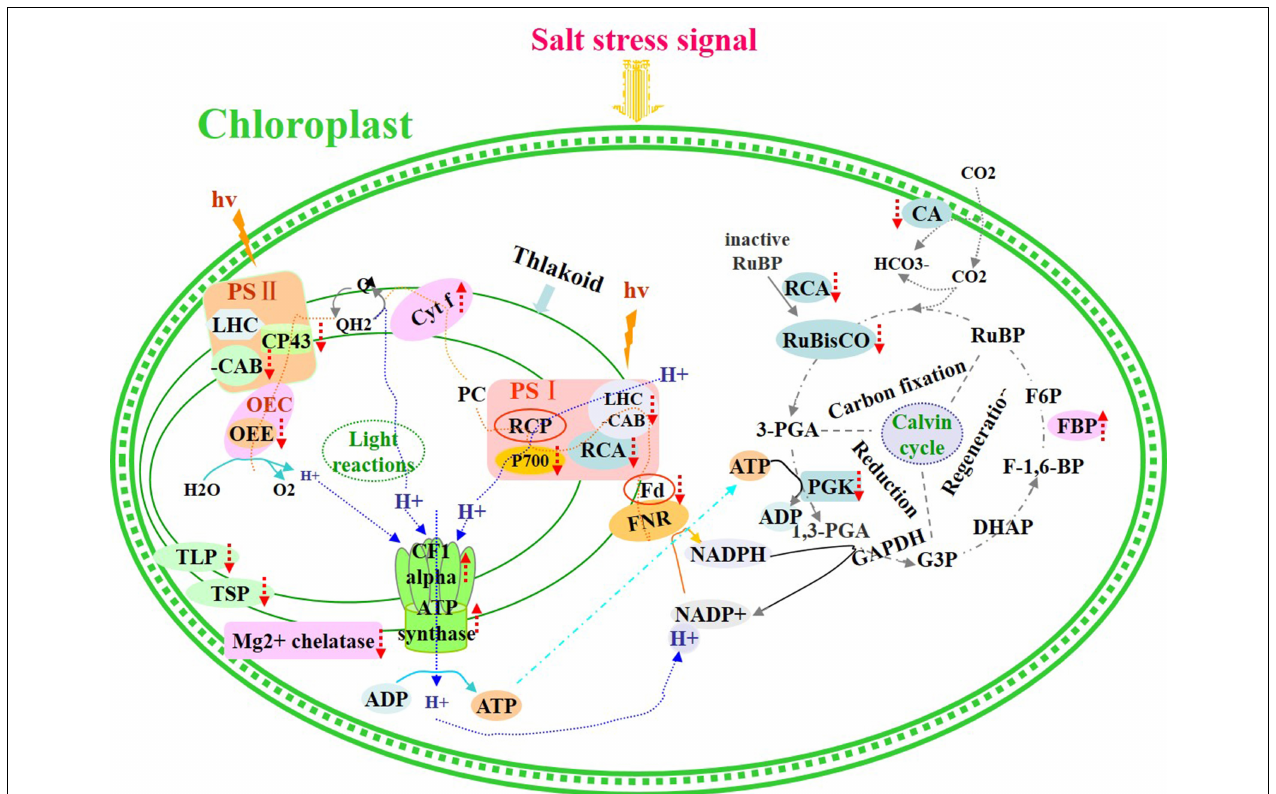
FIGURE 9 | Schematic presentation of salinity stress-responsive proteins involved in photosynthesis in T. Nitraria seedlings.